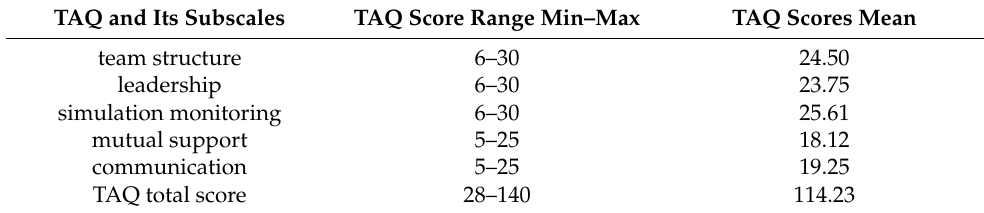
Table 2. TAQ subscale mean scores of nurses.